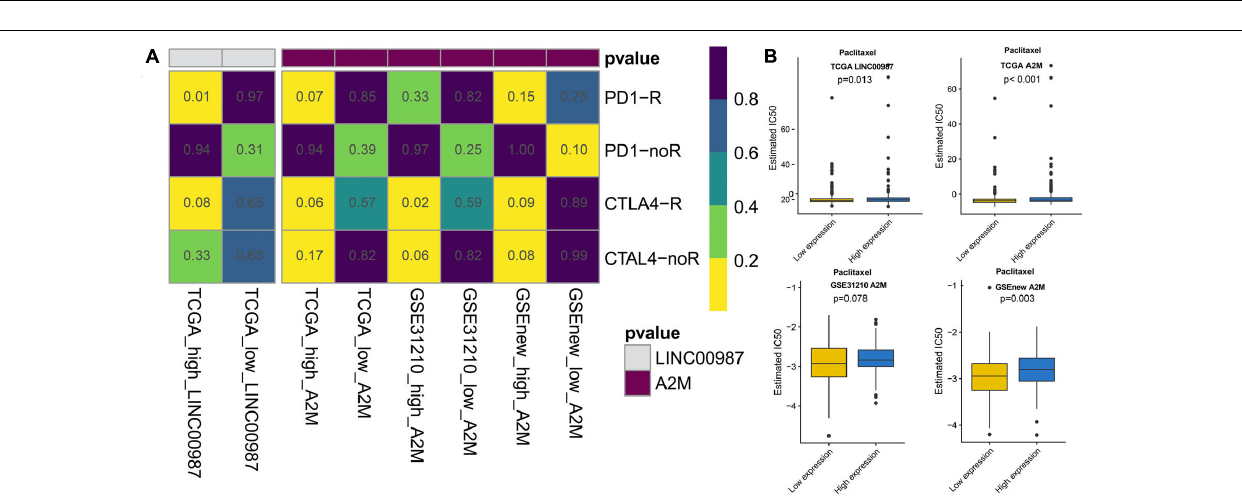
FIGURE 6 | Gene sets functional enrichment analysis. (A) GSEA of high vs. low expression of LINC00987. (B) GSEA of high vs. low expression of A2M in the TCGA cohort. Correlation of the expression of (C) LINC00987 and (D) A2M with hypoxia gene sets. Correlation of the expression of (E) LINC00987 and (F) A2M with tumor stem cell characteristics. * p < 0.05, *** p < 0.001, and **** p < 0.0001.